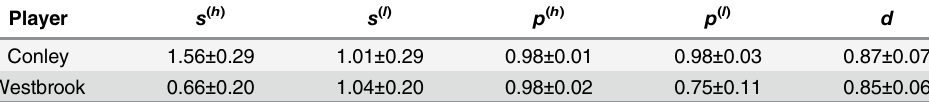
Table 1. Inferred skill values for Mike Conley and Russell Westbrook based on their performance in the first three games of the 2011 Memphis-OKC playoff series. The skills are based on the high/low model, defined in Sec. 2 and Fig 1, and are listed together with ± one standard error [see Eq (9)]. Player s ( h